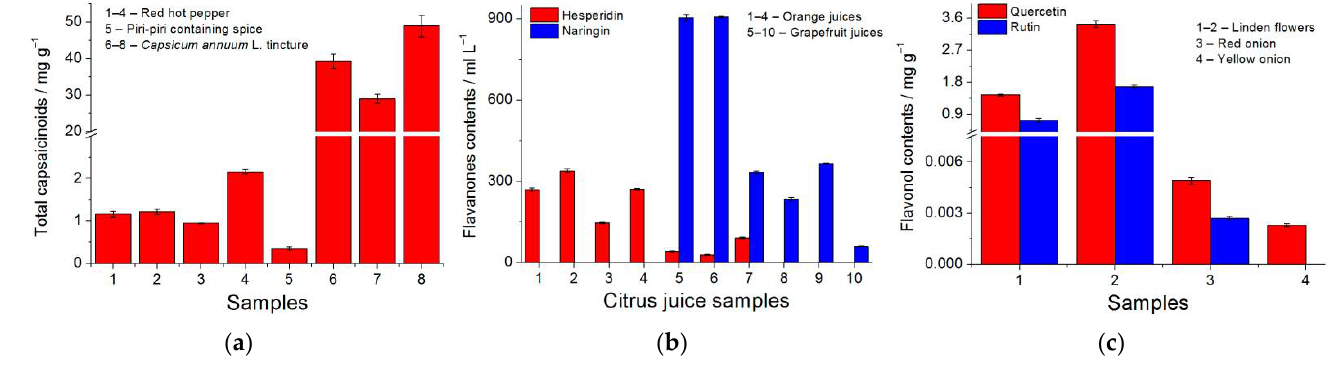
Figure 4. Quantification of antioxidants in food and plant samples: ( a ) total capsaicinoids in spices of red hot pepper and Capsicum annuum L. tinctures at poly(gallic acid)/MWCNTs/GCE in the Britton–Robinson buffer pH 2.0; ( b ) hesperidin and naringin in citrus juices at polyaluminon/f-SWCNTs/GCE in phosphate buffer pH 5.0 and at poly(ellagic ac-id)/MWCNTs/GCE in phosphate buffer pH 6.5; ( c ) quercetin and rutin in linden ( Tilia L.) flowers and onion at polythymolphthalein/CNF/GCE in phosphate buffer pH